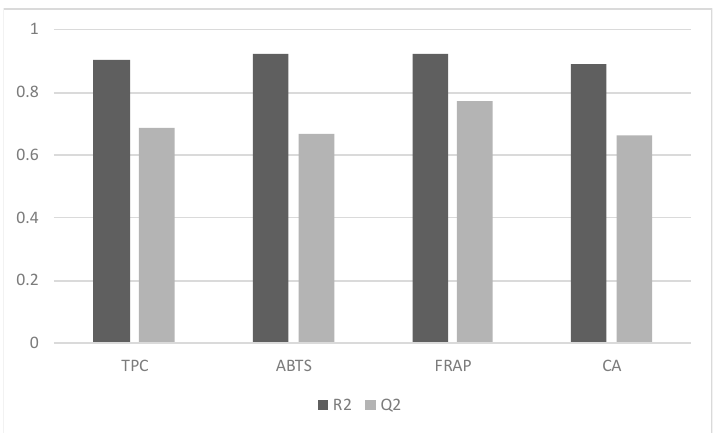
Figure 1. Statistic of the model—R2 and Q2 values of the four responses (TPC, total phenolic content; ABTS, diammonium 2,2 ′ -azino-bis(3-ethylbenzothiazoline-6-sulphonate); FRAP, ferric reducing antioxidant power; CA, chlorogenic acid).